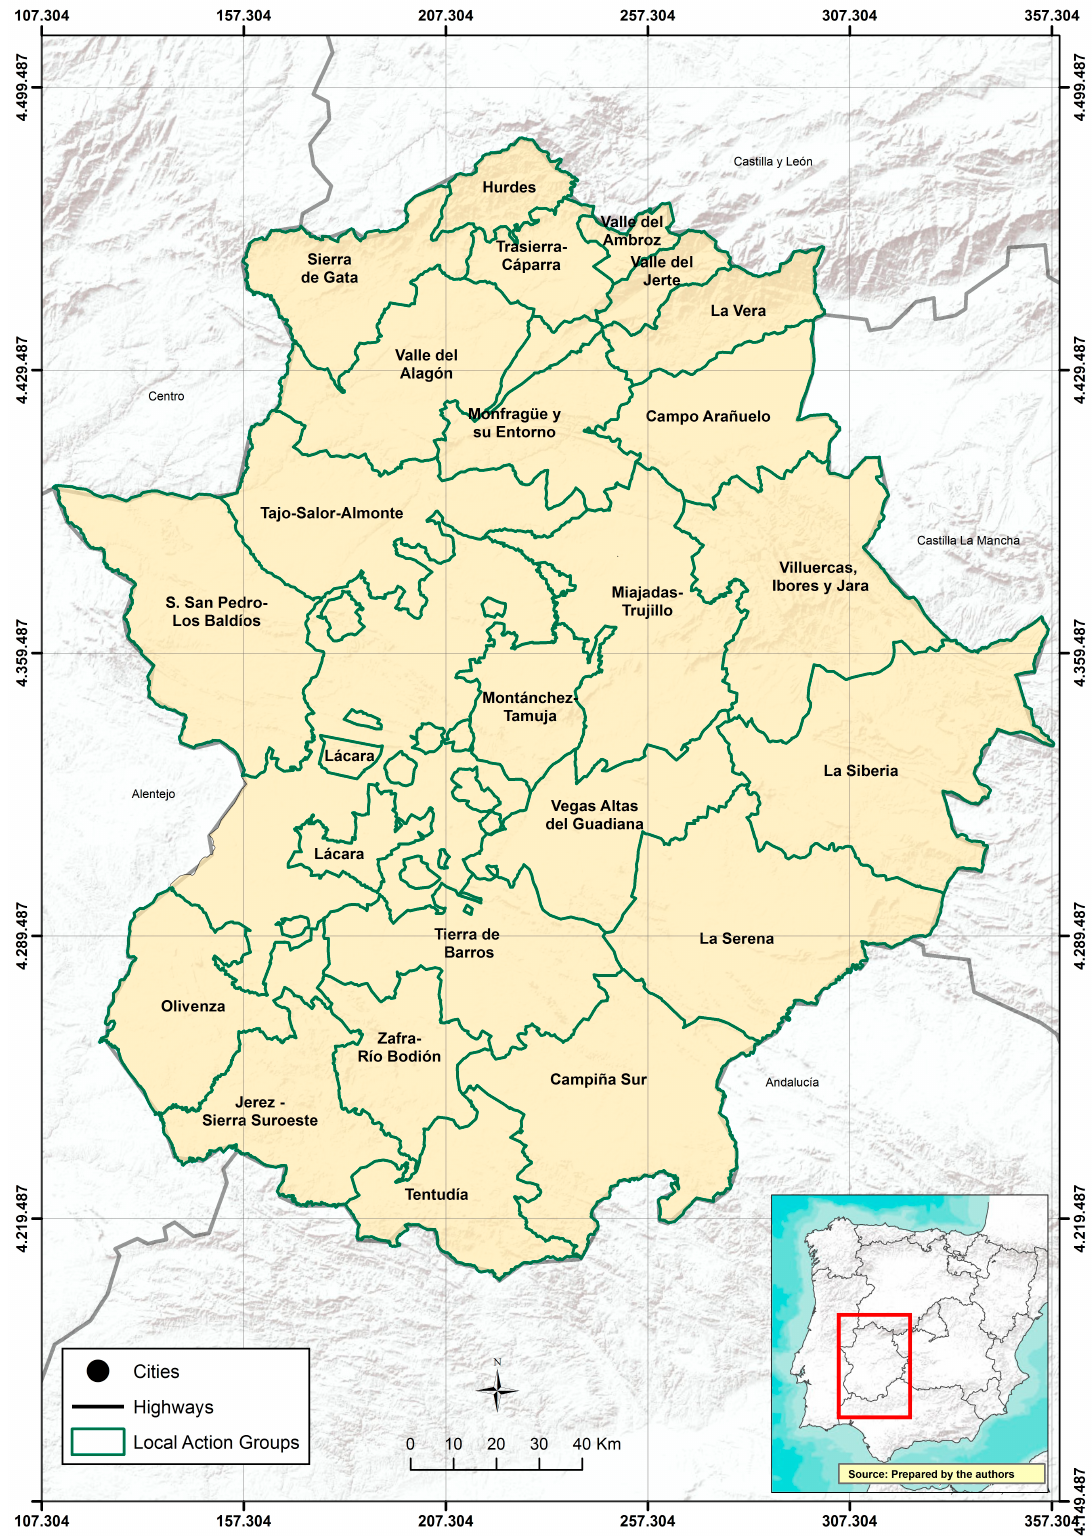
Figure 1. Study area of Extremadura (South Western Spain). Source: authors.